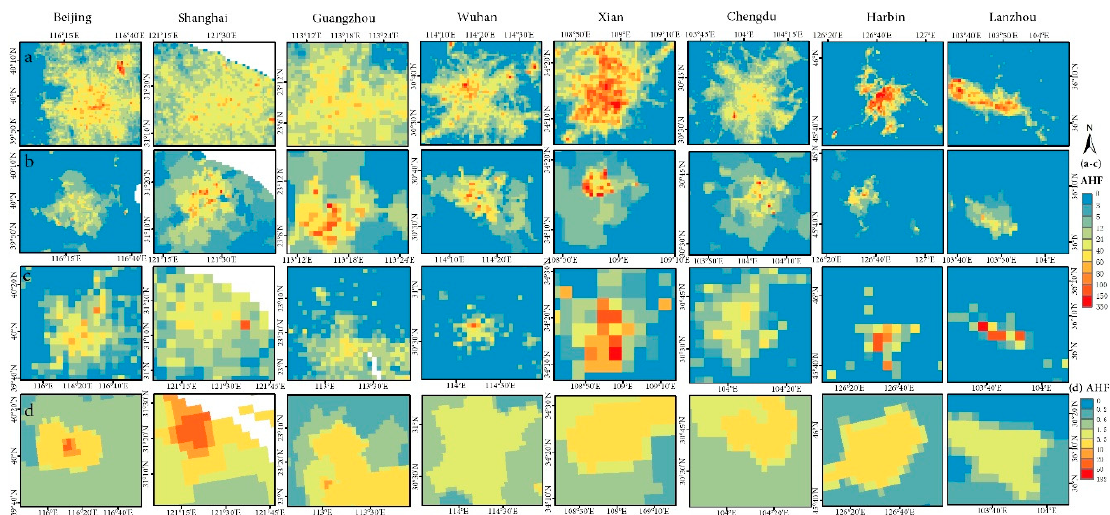
Figure 7. The comparison of the AHF results of the three models ( a ) The results of this study resampled to 1 km resolution. ( b ) The results of the large scale urban consumption of the energy (LUCY) model. ( c ) The results of this study resampled to 2.5 arc-min resolution. ( d ) The results of Flanner et al.